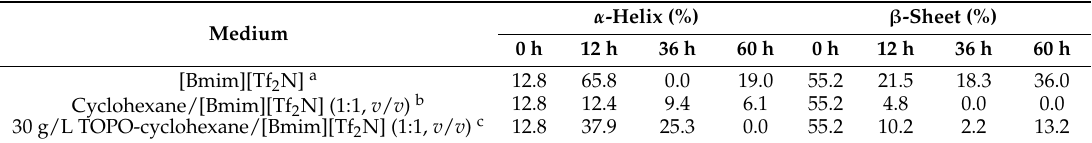
Table 3. Quantitative estimation (%) of the secondary structure elements of treated Novozym 435 calculated by FTIR analysis in the amide I region under different media.